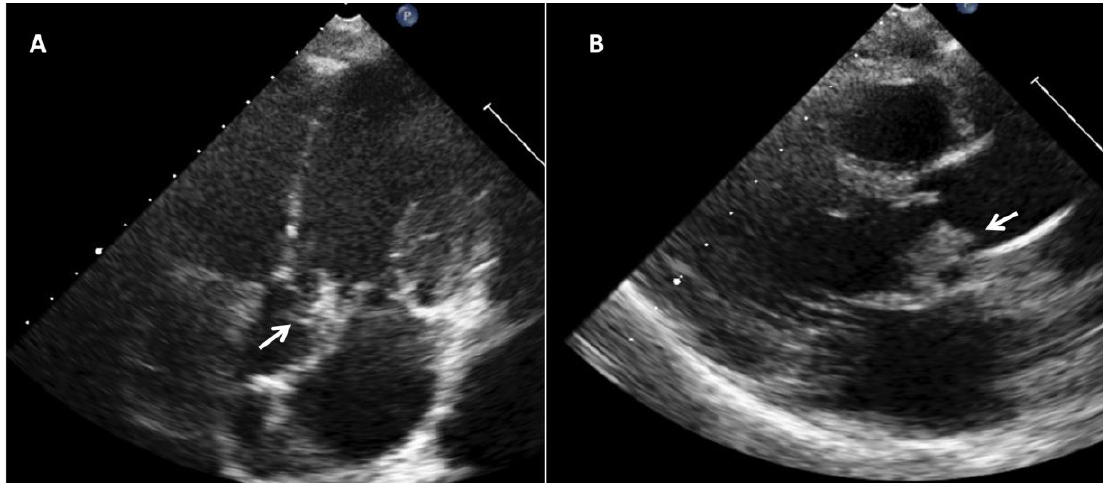
Figure 4. Infective endocarditis in a 13-year-old boy with bicuspid aortic valve due to Aggregati- bacter aphrophilus (HACEK group). ( A ) Apical 5-chamber view showing aortic valve vegetation. ( B ) Paraesternal long axis with aortic valve showing aortic valve thickening and vegetation.